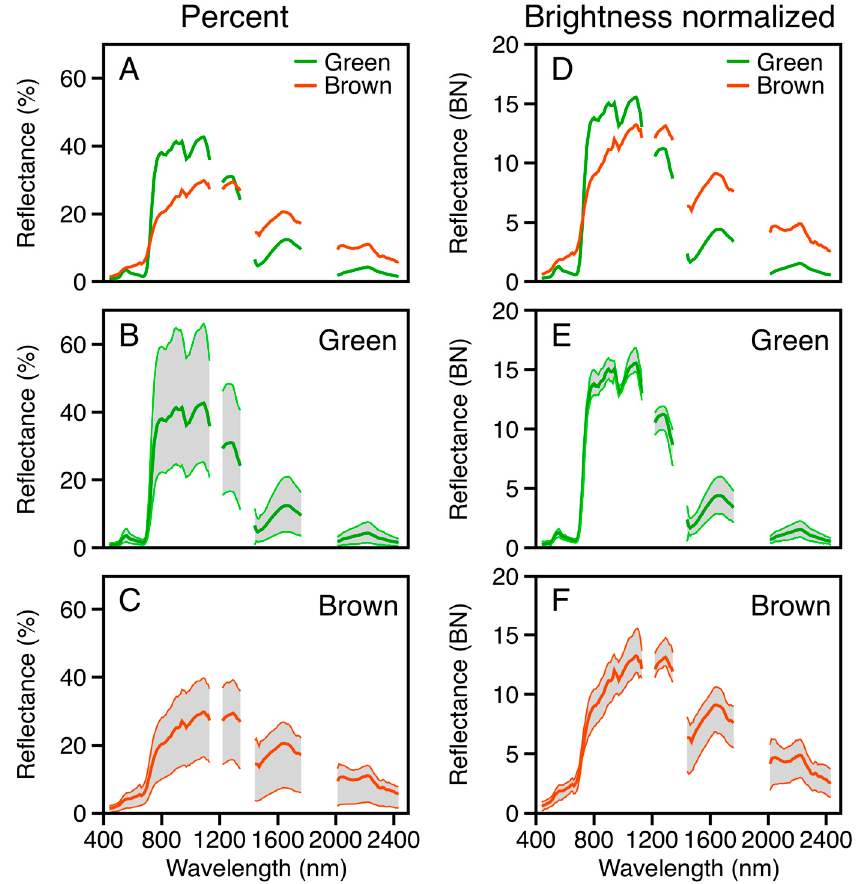
Figure 6. Comparisons of mean green and brown canopy reflectance and brightness-normalized canopy reflectance are shown in ( A , D ), respectively, followed by mean, minimum and maximum reflectance values for green ( B , E ) and brown ( C , F ) foliage.